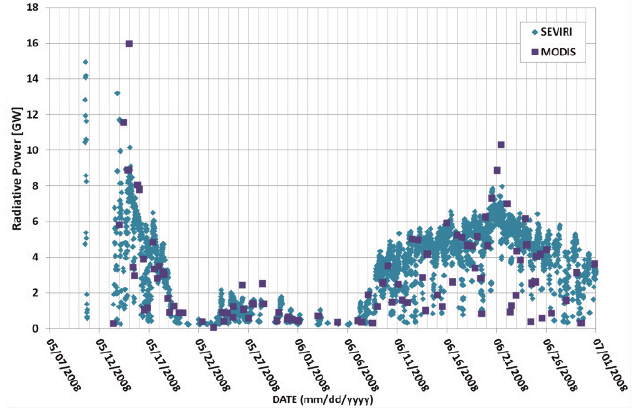
Figure 6. Radiative power computed for the SEVIRI (green) and MODIS (violet) data during May and June,